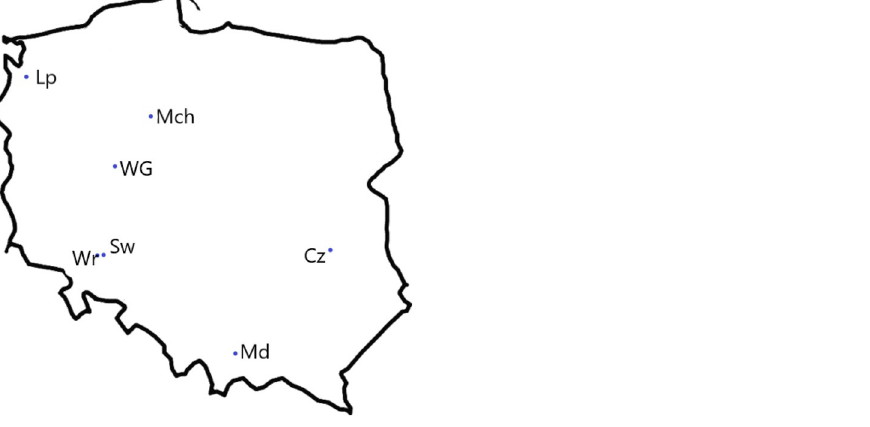
Figure 8. Study site distribution. Lp Lipnik; Mo Mochełek; WG Winna Góra; Cz Czesławice; Sw Swojczyce; Wr Wrocław; Md Mydlniki.